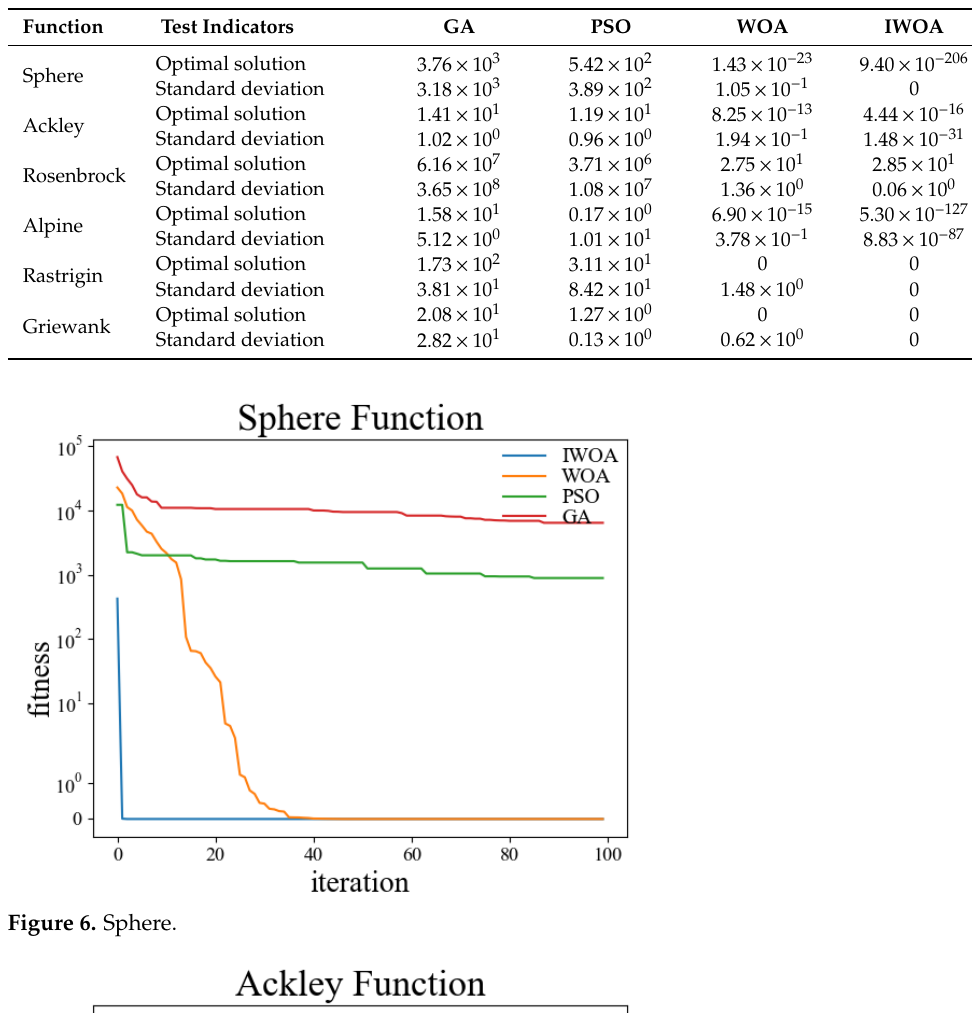
Figure 6. Sphere.